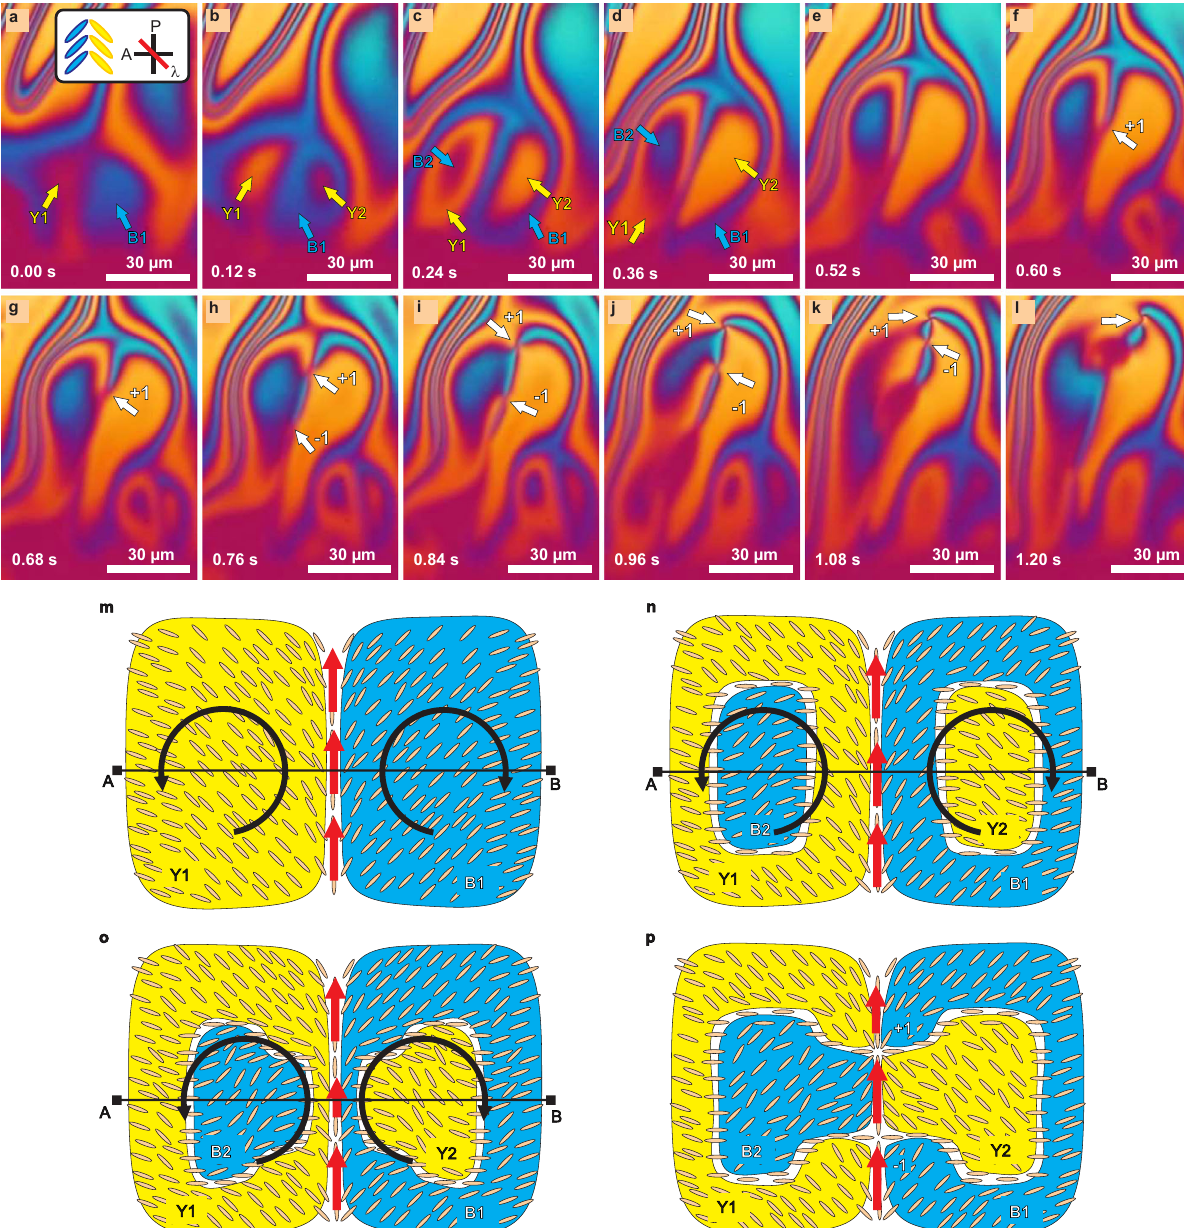
Fig. 4 | Experimental and schematic display of topological defect creation. a – l The sequence of λ -plate images shows topological defect creation and annihi- lation. a Neighboringregionsofyellowontheleft(Y1)andblueontheright(B1)are formed. Between them the liquid crystal (LC) fl ows toward the LC core above. b , c Inside the primary regions, islands B2 and Y2 are formed. d , e When the fl ow velocitydecreases,theneighboringstripsofY1andB1thinout. f , g Theneighboring strips of Y1 and B1 disappear, which is followed by the creation of a defect. One defect(markedbyawhitearrow)canalreadybeobserved,whiletheotheroneonly becomesobservablein( h ). i – l Astheymove,thedefectscomeclosertoeachother